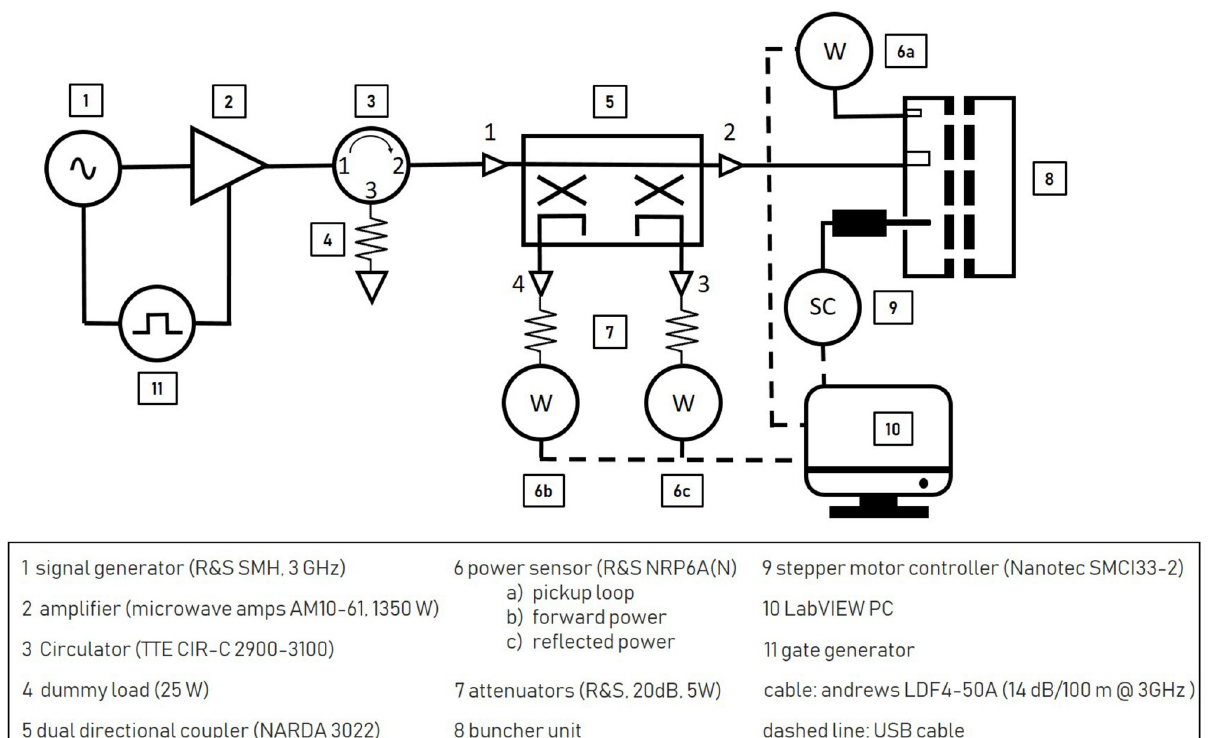
Fig 8. Schematic representation of frequency tuning- and RF system of the two buncher